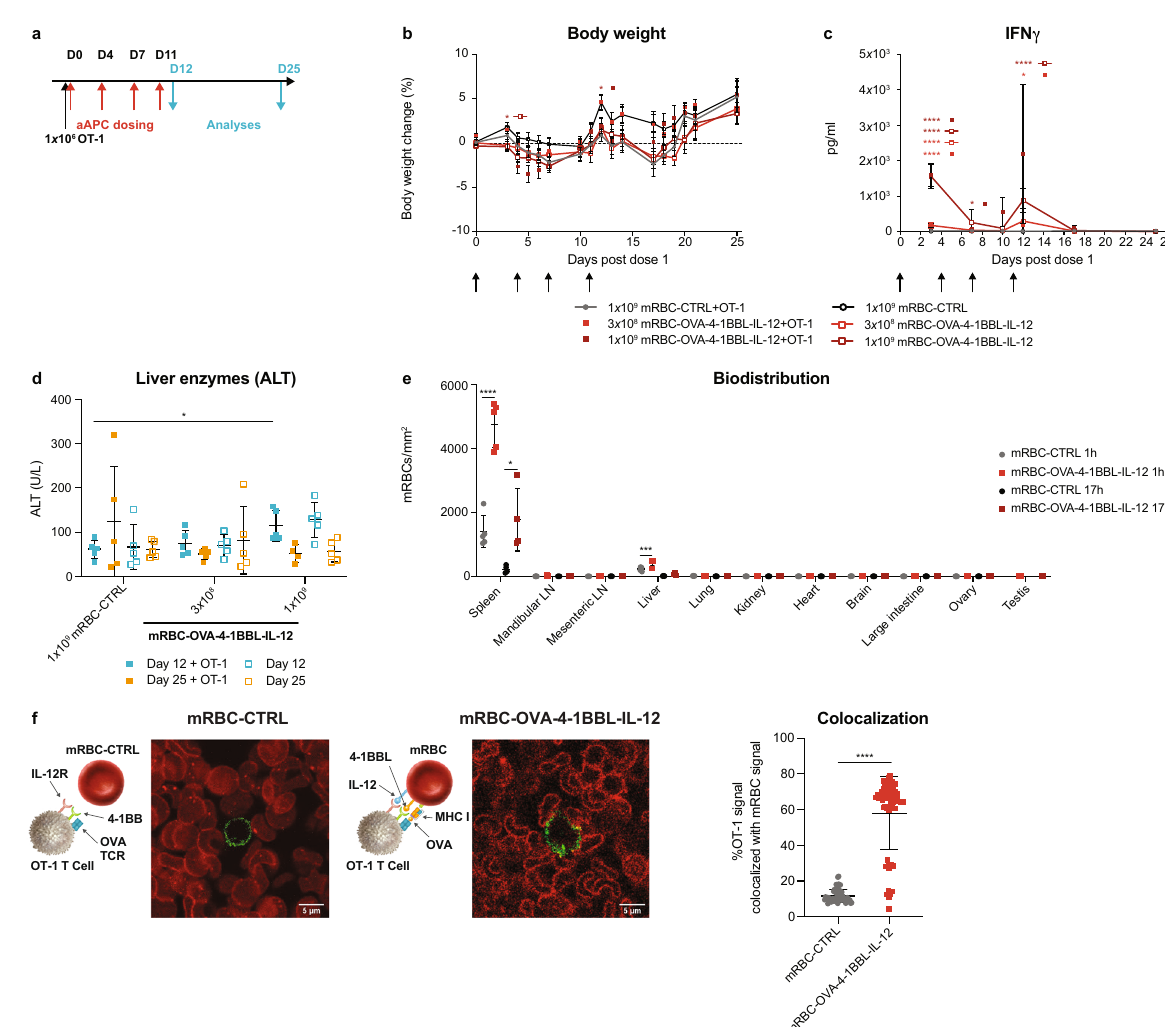
Fig. 2 mRBC-OVA-4-1BBL-IL-12 was well tolerated, with preferential biodistribution to the spleen to facilitate T-cell interaction. a CD45.1 Pep Boy mice ( n = 10) were treated with 1 × 10 6 naïve OT-1 cells or left untreated, and either dosed with 1 × 10 9 mRBC-CTRL or a dose titration of mRBC-OVA-4-1BBL-IL- 12 (1 × 10 9 , 3 × 10 8 ) on days 0, 4, 7, and 11. n = 5 were killed on day 12, with n = 5 measured for time points post day 12 for all groups except for n = 4 for mRBC-OVA-4-1BBL-IL-12 + OT-1. b Body weight changes compared to day 0. Two-way ANOVA compared to mRBC-CTRL; day 3: 1 × 10 9 P = 0.019; day 12: 1 × 10 9 + OT-1 P = 0.048. c Plasma IFN γ levels over time. n = 10 for days 3 and 7; n = 5 post day 10 except for n = 4 for mRBC-OVA-4-1BBL-IL-12 + OT-1 on days 17 and 25. Two-way ANOVA compared to mRBC-CTRL; day 3: 3 × 10 8 and 1 × 10 9 P < 0.0001, 3 × 10 8 + OT-1 P = 0.0002, 1 × 10 9 + OT-1 P < 0.0001; day 7: 3 × 10 8 + OT-1 P = 0.018; day 12: 3 × 10 8 + OT-1 P = 0.025, 1 × 10 9 P < 0.0001. d Serum ALT levels on days 12 and 25. One-way ANOVA compared